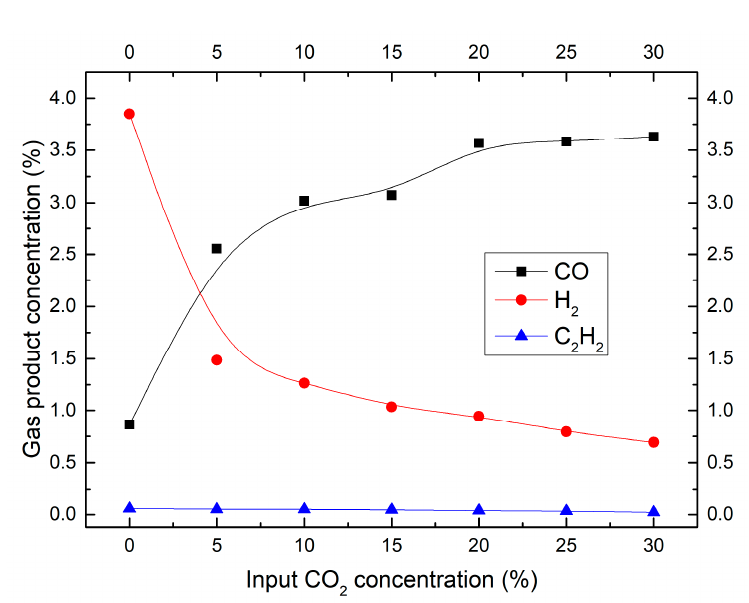
Figure 11. Effect of CO 2 concentration on the composition of the off-gas.